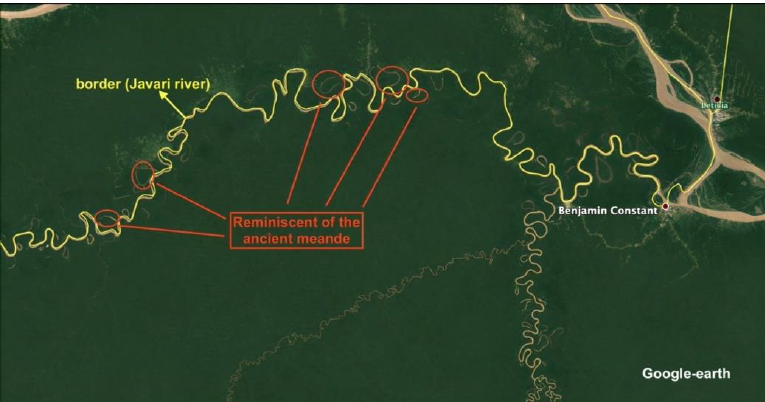
Figure 12 . Reminiscent signs of the ancient meanders of Javari